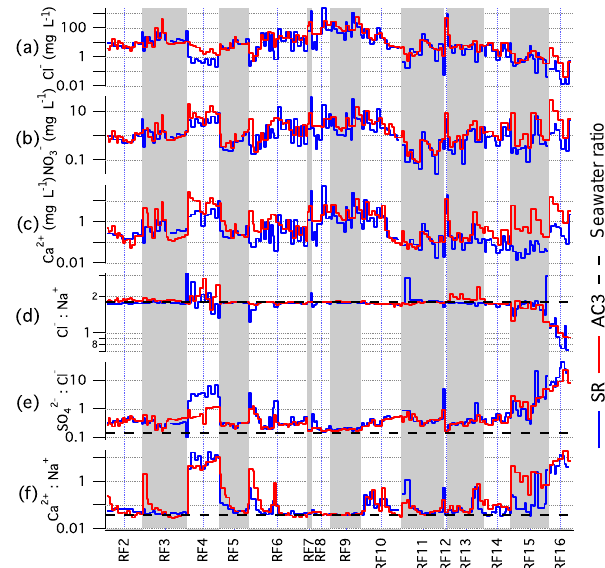
Figure 12. Pseudo-time series of selected chemical species concen- tration (a–c) and ratios (d–f) observed during the intercomparison between AC3 and the slotted rod (SR) as part of the FASE cam-